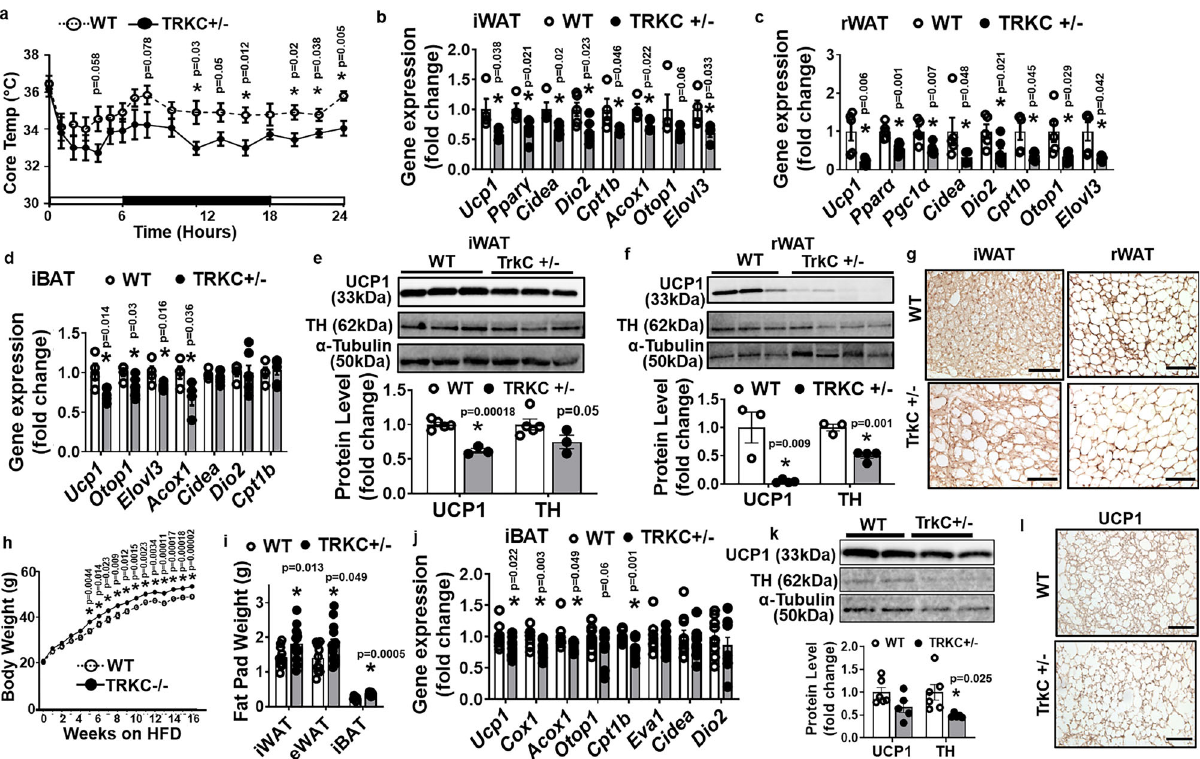
Fig. 8 Mice with haploinsuf fi ciency of TRKC exhibit impaired cold-induced thermogenesis and are prone to diet-induced obesity. a – d Body temperature ( a , WT n = 8, TRKC + / − n = 6, * indicates statistical signi fi cance between WT and TRKC + / − with unpaired two-tailed t test), and Ucp1 and other thermogenic gene expression in iWAT ( b , WT n = 4, TRKC + / − n = 5), rWAT ( c , WT n = 5, TRKC + / − n = 6) and iBAT( d , WT n = 4, TRKC + / − n = 5) of WT and TRKC + / − mice during a 7-day cold exposure (* indicates statistical signi fi cance between WT and TRKC + / − with unpaired two-tailed t test). e – g UCP1 and TH protein levels in iWAT ( e , WT n = 5, TRKC + / − n = 3, * indicates statistical signi fi cance between WT and TRKC + / − with